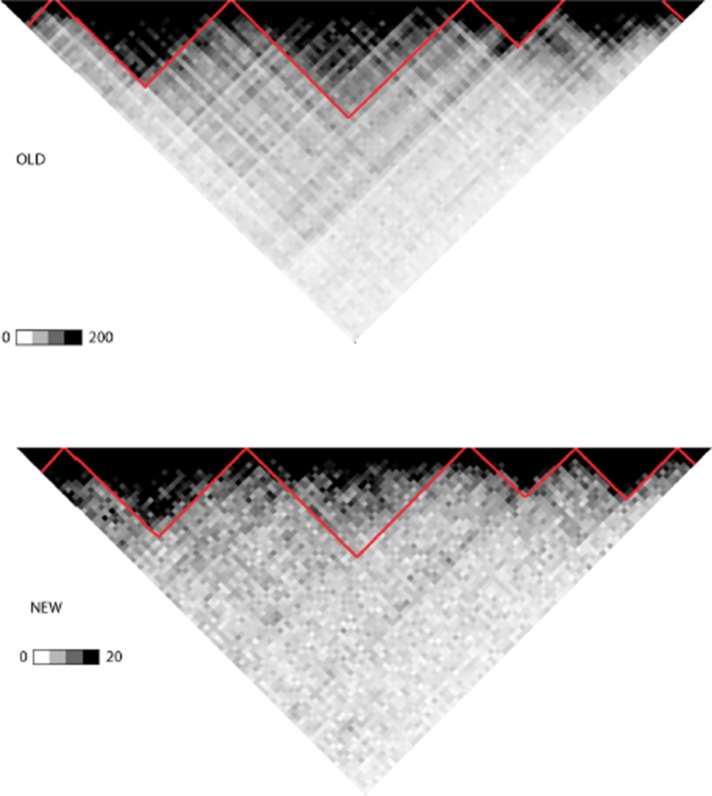
DOI:
http://dx.doi.org/10.7554/eLife.13087.036